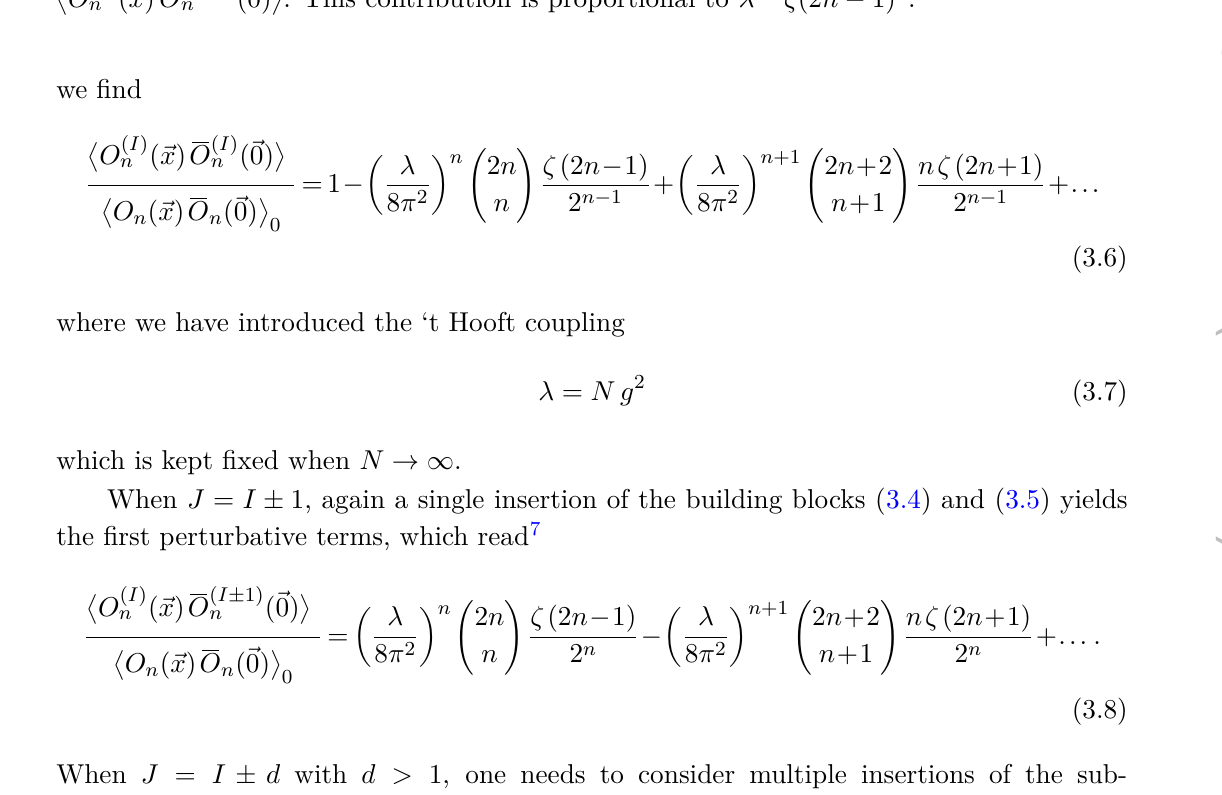
Figure 3 : The diagram describing the leading contribution to the 2-point function (cid:10) O ( I ) ( ~x ) O ( I ± d ) ( ~ 0) (cid:11) . This contribution is proportional to λ nd ζ (2 n − 1) d n n